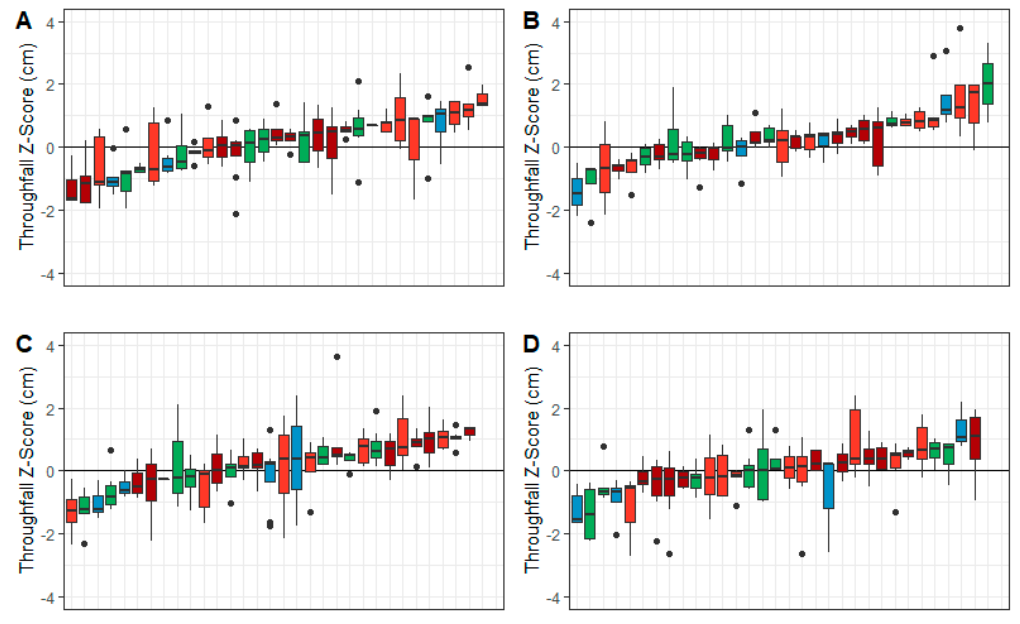
Figure 5. Rank of overstory throughfall gauges by species and median z-score in the ( A ) leaf-off canopy phase next to the tree bole, ( B ) leaf-off canopy phase at the mid-canopy point, ( C ) leaf-on canopy phase next to the tree bole, and ( D ) leaf-on canopy phase at the mid-canopy point. Species codes: ACRU = red maple, CATO = mockernut hickory, QUFA = southern red oak, QUAL = white oak.